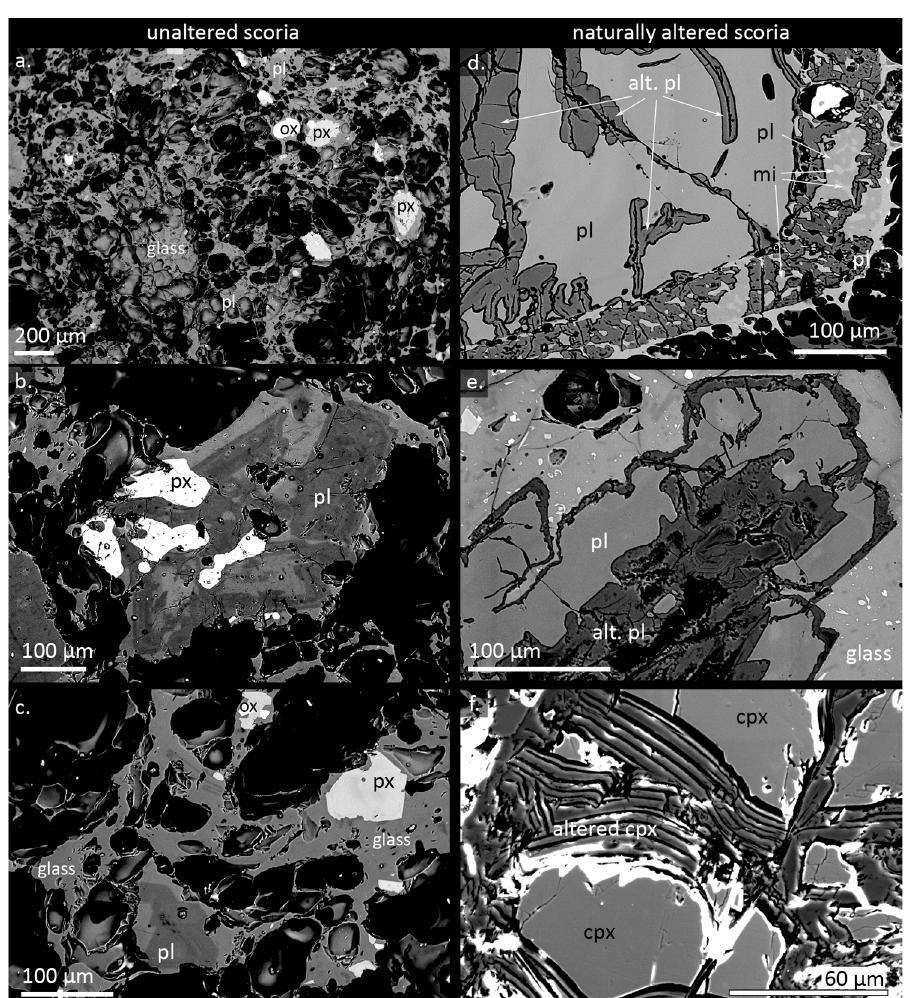
Figure 2. Back-scattered electron images of the starting andesite scoria ( a–c ) and a naturally altered scoria from the same eruption ( d–f ). ( a ) Overview showing phenocrysts of plagioclase, clinopyroxene and titano-magnetite in a porous, glassy matrix. ( b ) Zoned plagioclase phenocryst cluster with clinopyroxene. ( c ) Sharp, angular boundaries between phenocrysts and matrix glass. ( d ) Partially altered plagioclase with preservation of melt inclusions (mi) and matrix melt. The plagioclase has been altered to opaline silica. ( e ) Plagioclase with altered rim and core showing the strong control of compositional zoning on alteration. ( f ) Typical alteration texture of clinopyroxene with layered appearance of the opaline silica alteration product. Abbreviations used are pl—plagioclase;